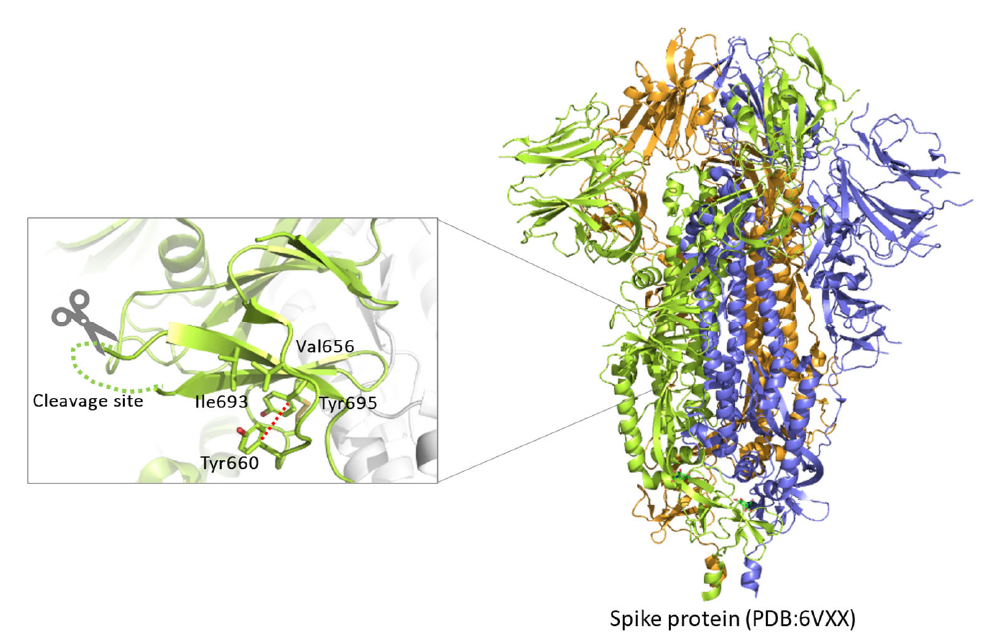
Figure 5. Cartoon view of spike glycoprotein trimers in closed conformation (right panel, PDB 6VXX). Zoomed view (left panel) of one of the cleavage sites: side chains (sticks view) of residues forming an adjacent hydrophobic cleft are evidenced, and the stacking interaction is traced (red dashed line).